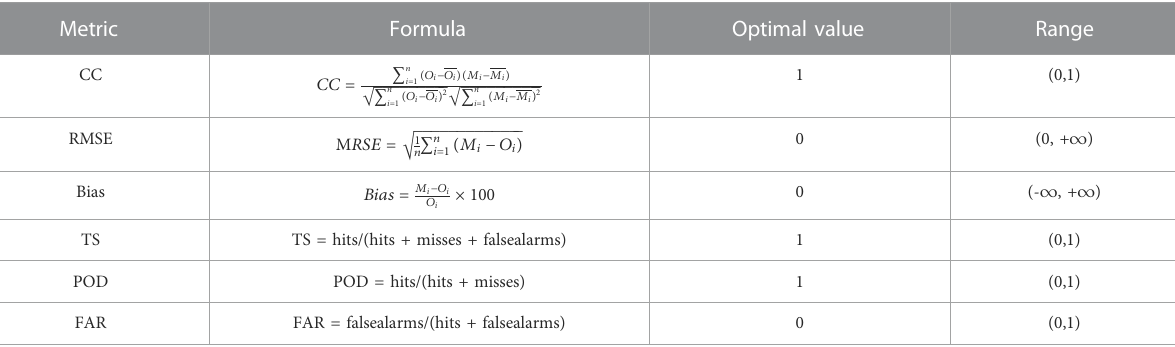
TABLE 3 De fi nition of evaluation